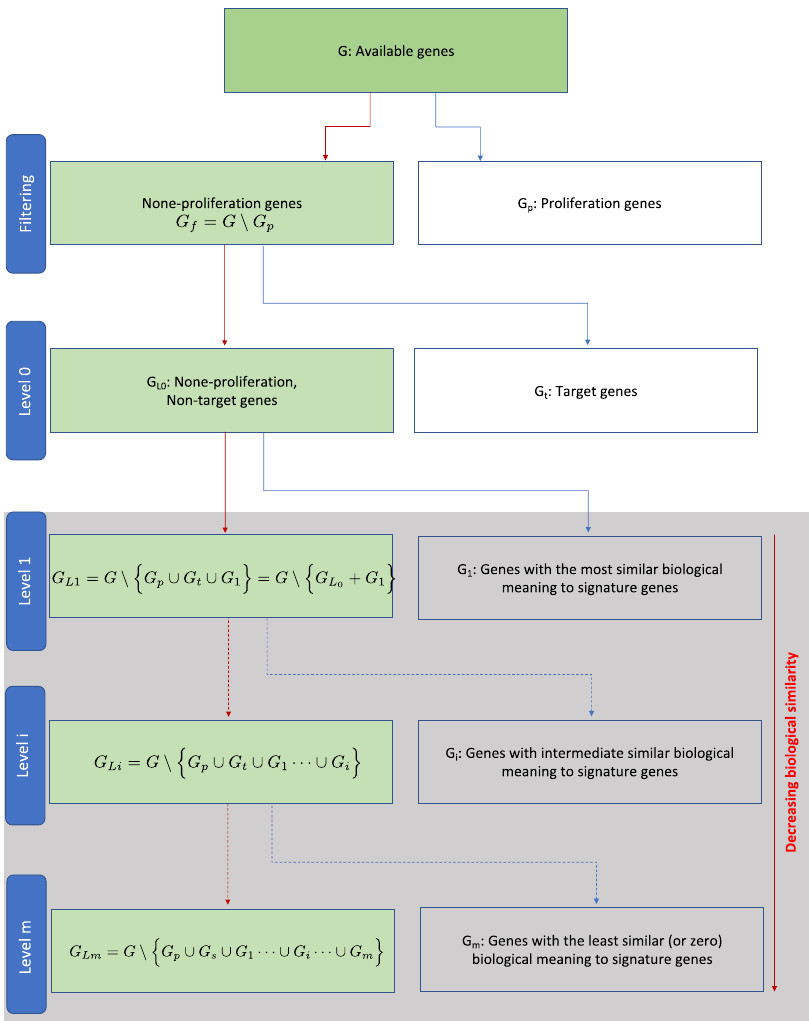
Fig. 4 Procedure for preparation of a gene pool for severe testing. Removal of proliferation genes, G p , can be seen as fi ltering. The genes resulting from each step thereafter (level 0 to m ) can be used for severe testing, whereas the stringency increases with increasing levels, i.e., the genes on level 1 result in the least stringent test, whereas the genes on level m allow the most stringent test.